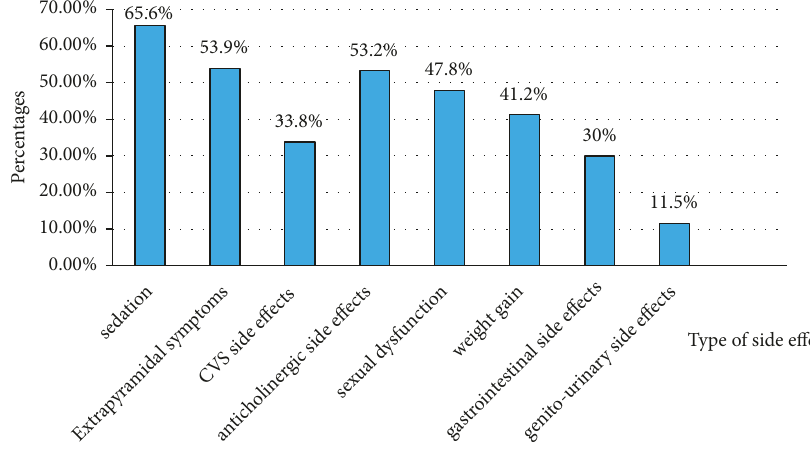
Figure 1: Magnitude of antipsychotics side effects among patients with schizophrenia at AMSH, 2018.